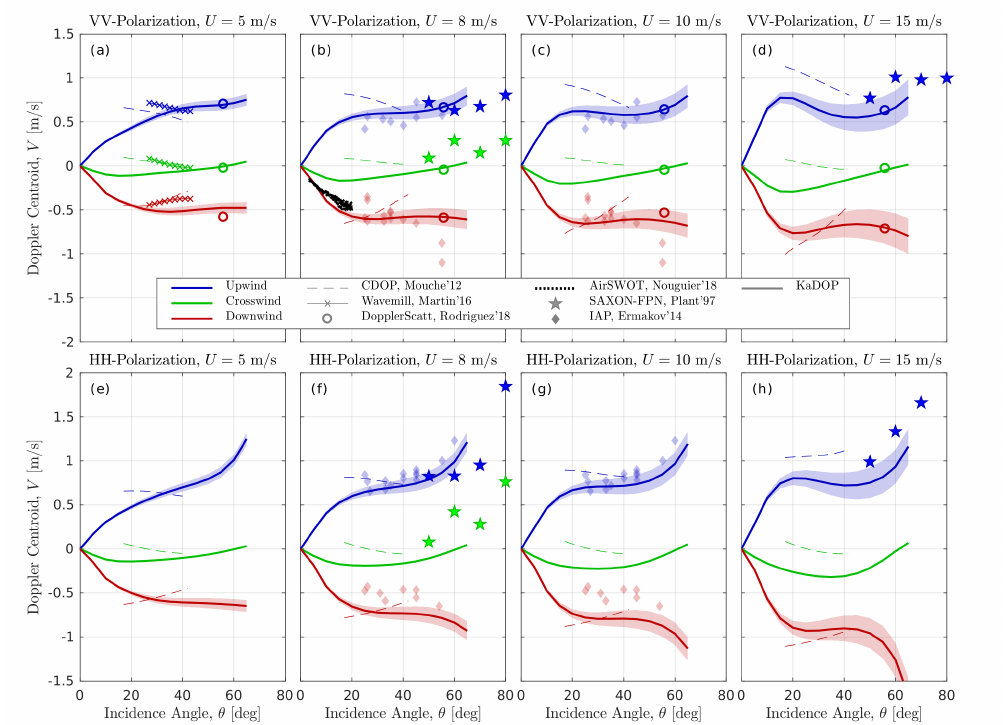
Figure 8. Doppler centroid versus incidence angle for various wind speeds, left to right: U = 5,8,10,15 m/s. ( top row ) VV-polarization, ( bottom row ) HH-polarization. Confidence interval corresponds to wind drift variation from 0 to 3% U .